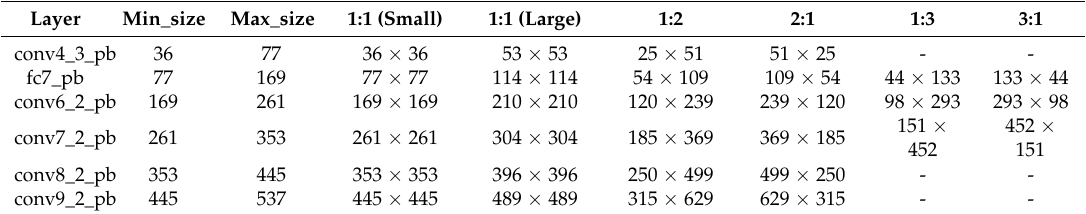
Table 3. The learned average default box size for each feature map cell in different concatenated feature layers using the extend VGGNet (512 × 512